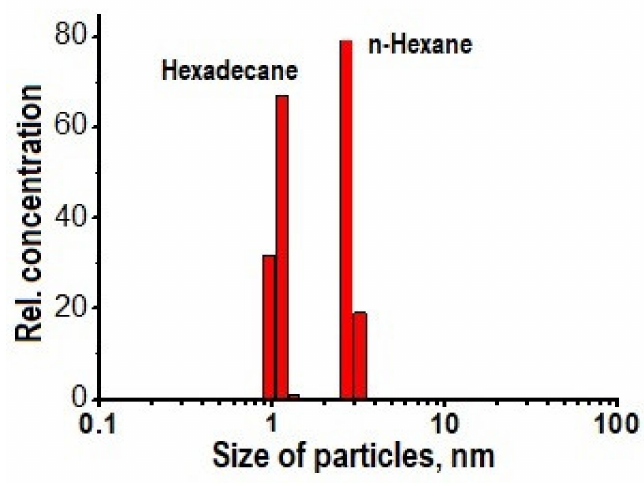
Figure 12. Examples of nanoparticles detected in processed hydrocarbons.